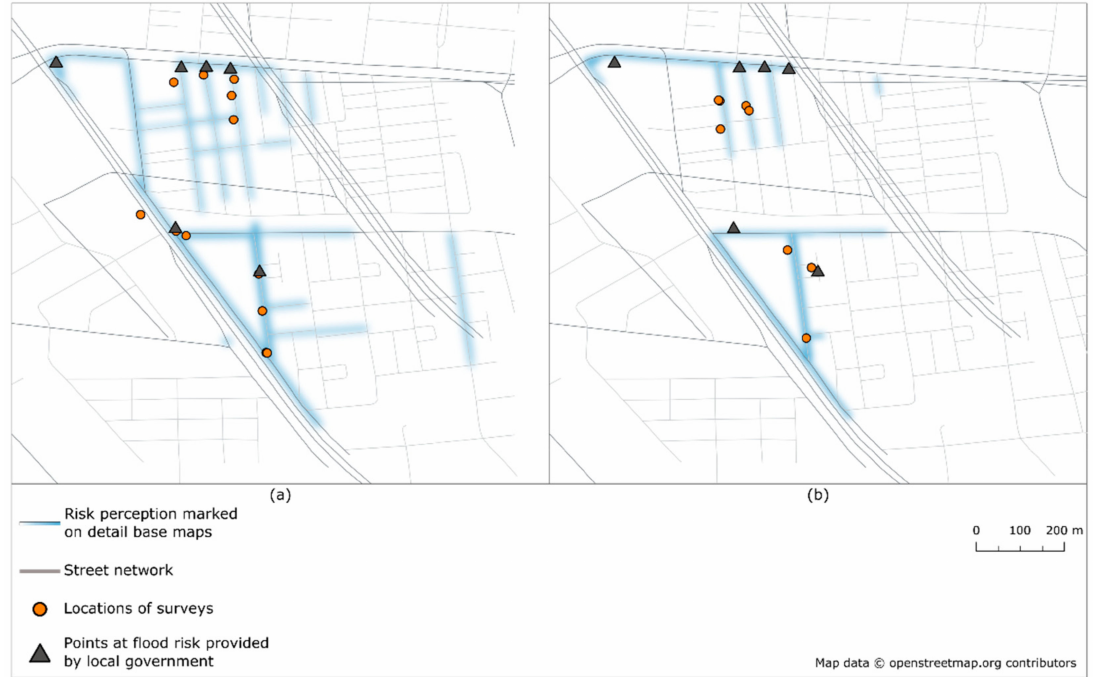
Figure 7. Risk perception based on the detail maps in the north of La Florida (blue). Pedestrians ( a ) tend to overestimate the area at risk in comparison to residents ( b ). All perceive the same areas at risk as the local government (triangles). The orange points indicate the position of the people during the